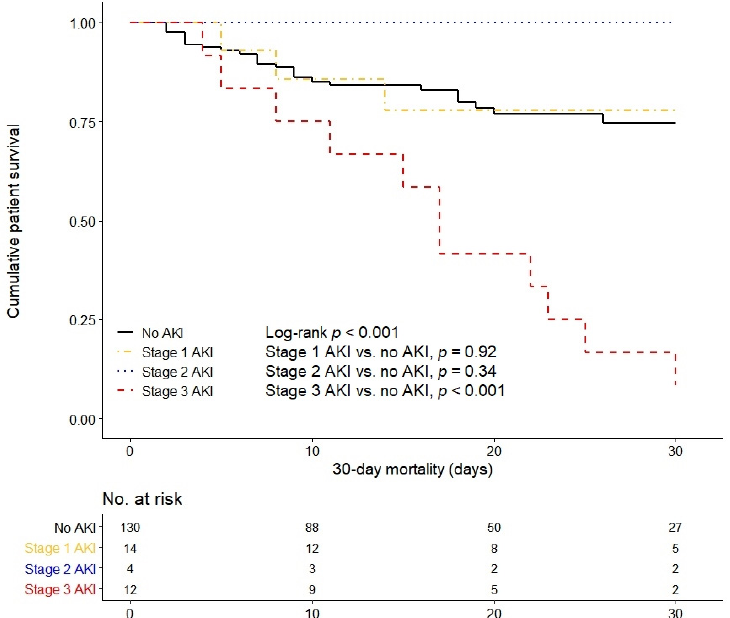
Figure 1. Kaplan–Meier survival curve for 30-day mortality based on the severity of acute kidney injury. Table 4. Effect of AKI on mortality among all hospitalized COVID-19 patients.